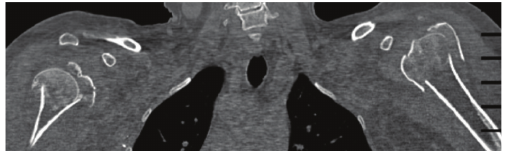
Figure 2: Coronal view of the CT of both shoulders demonstrating four-part proximal humeral fractures bilaterally.